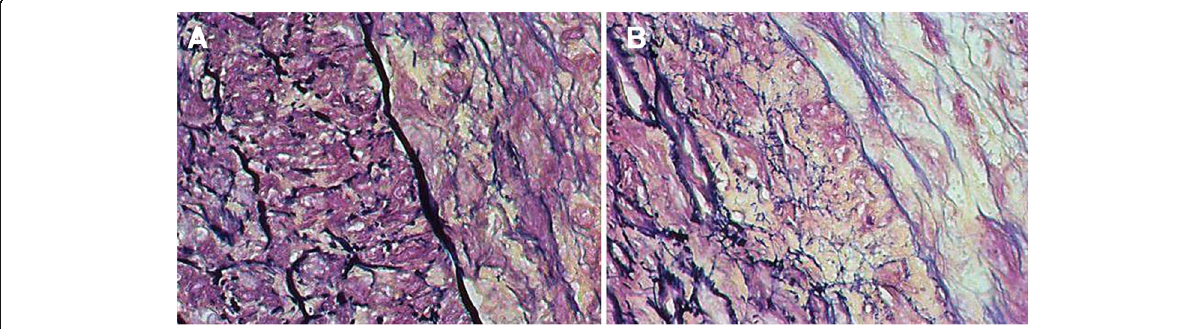
Fig. 3 a Histological section stained with verhoeff seen under common light, 1250x final increase of an elderly patient with Aids, showing a greater amount of elastic fibers, evidenced by the blackened coloration. b Histological section stained with verhoeff seen under common light, 1250x final increase of an elderly patient without AIDS, showing a smaller amount of elastic fibers, evidenced by the blackened